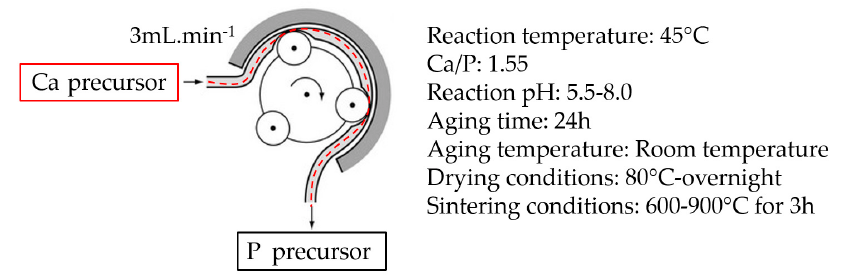
Figure 1. The scheme of the nanoparticle synthesis procedure.